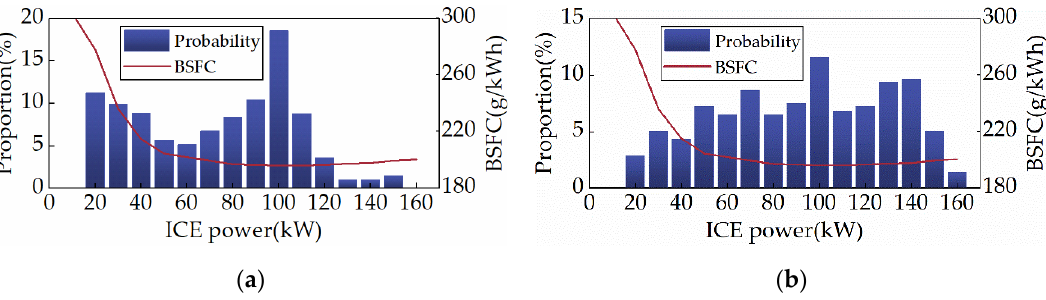
Figure 20. ICE power distribution under different driving cycles. ( a ) CHTC-B; ( b ) WVUCITY. Table 6. Fuel consumption in simulation of initial SOC = 0.6. Driving Cycle